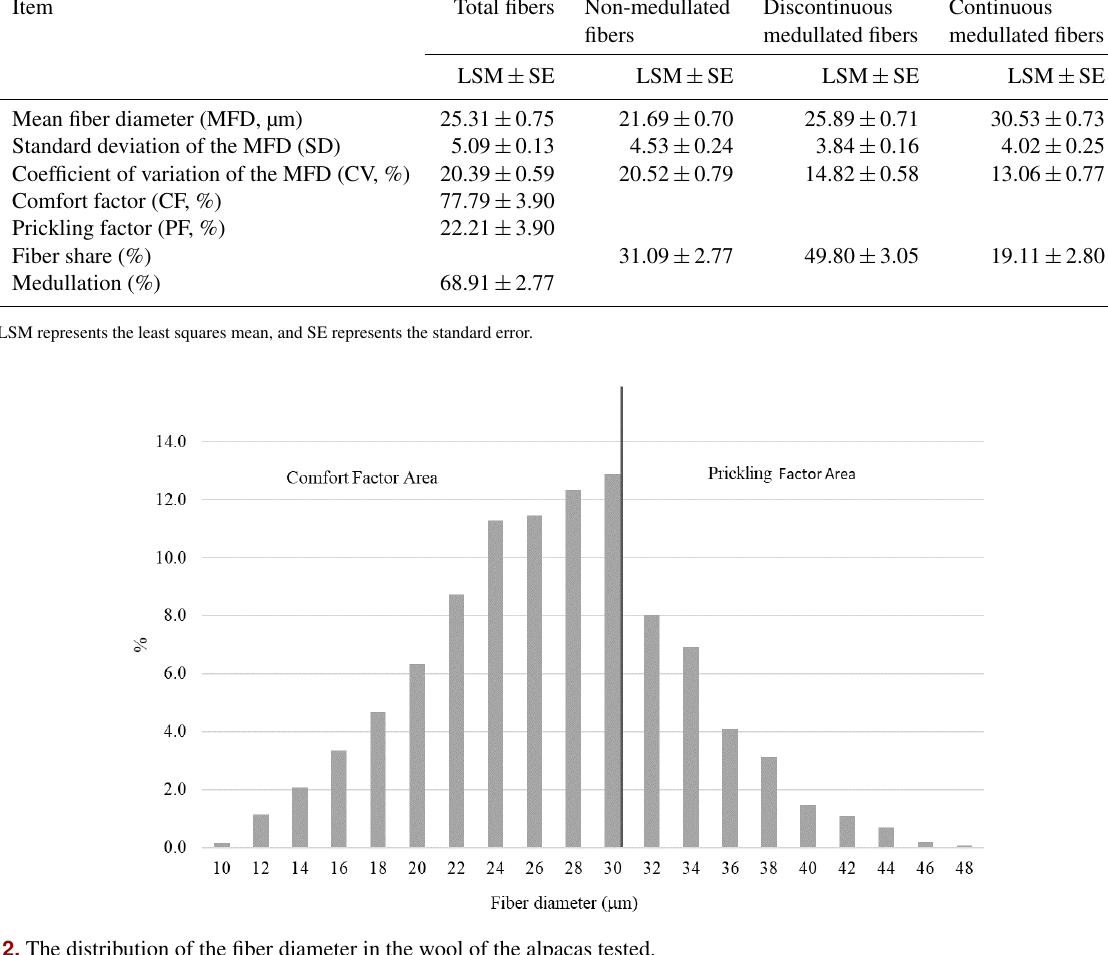
(2008) showed that males alpacas from the Huancavelia re- gion, located between 4100 and 4700 ma . s . l . , were charac- terized by a smaller average fiber diameter compared with females. Wuliji et al. (2000) and Lupton et al. (2006) indi- cated no differences in wool thickness with respect to sex in their respective studies on alpacas from New Zealand and the